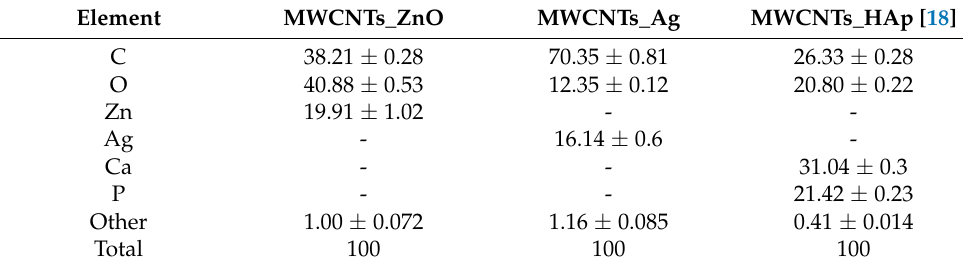
Table 3. Chemical composition (EDX) of MWCNTs decorated with